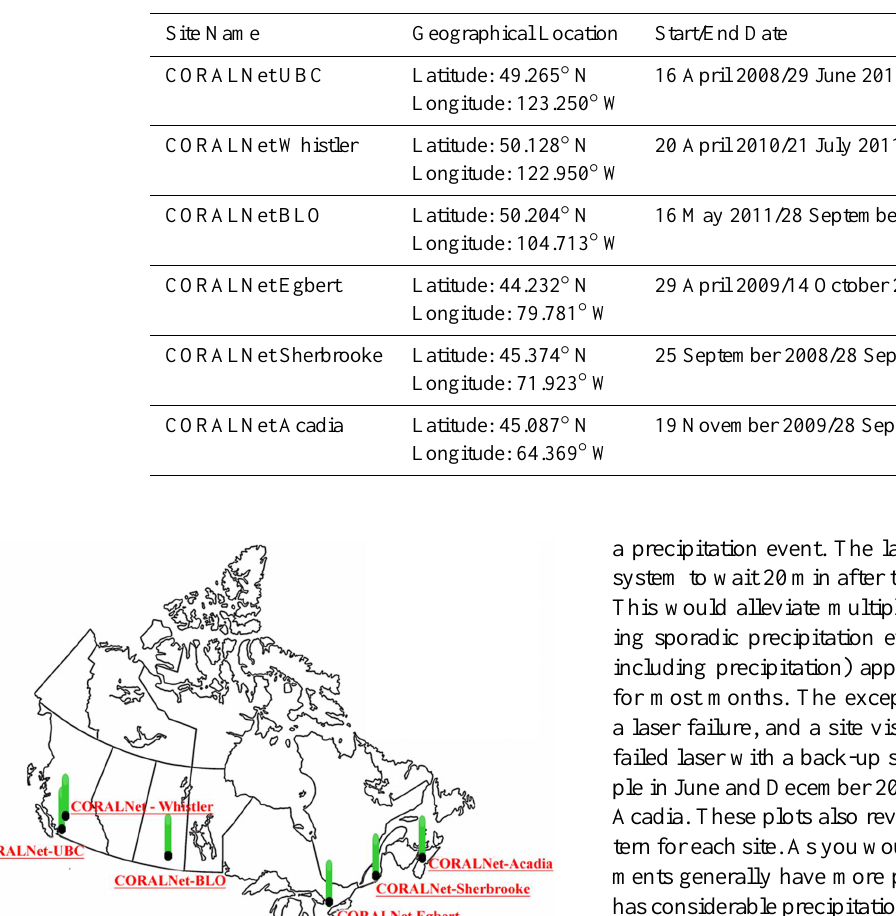
Table 2. Geographical location and operational period for each site in the Canadian Operational Research Aerosol Lidar Network (CORAL- Net).